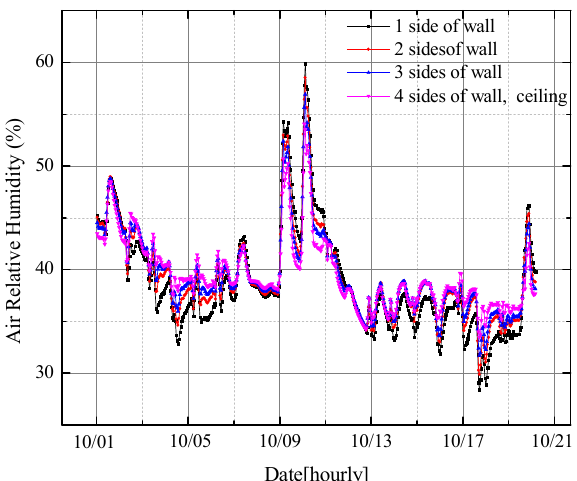
Figure 11. Relative humidity by zone using different amounts of hygroscopic materials.